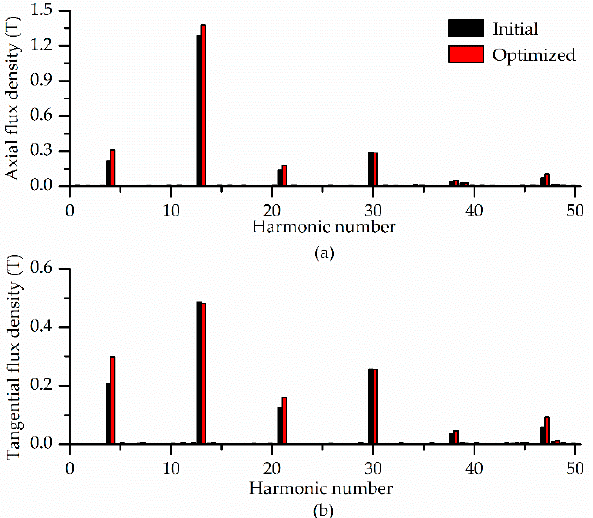
Figure 13. FFT analysis of the axial and tangential flux densities at the radius of R m3 in the LG of the HAMG. ( a ) Axial flux density; ( b ) Tangential flux density. Table 8. Amplitudes, the phase differences and torque due to the air-gap flux density at the radius of R m2 .